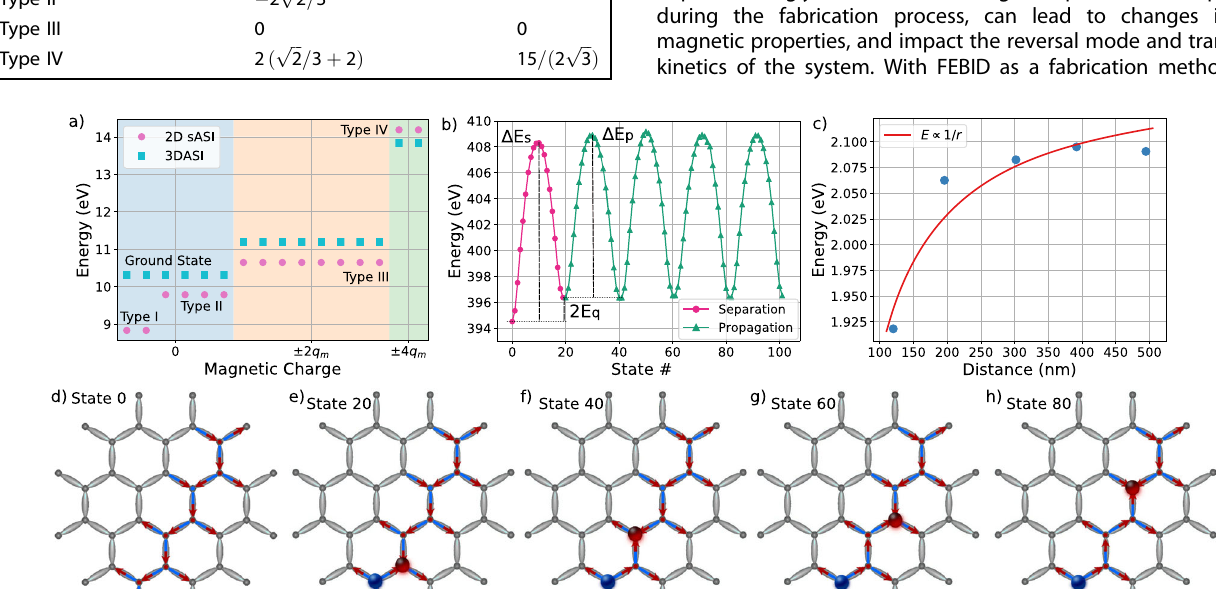
Fig. 2 Magnetostatic energies and minimum energy paths for propagation and separation of charges. a Total energies per vertex calculated with a micromagnetic treatment by taking into account energetic contributions of the exchange and demagnetization fi elds, where every possible magnetic con fi guration in a 2DsASI (circles) and in our 3DASI (squares) was considered, as illustrated in Supplementary Figs. 3, and 4, respectively. b Minimum energy paths to separate (magenta) the two magnetic charges by switching one ellipsoids magnetization in the ground state, and propagating it further through the lattice in a constant direction (green). The difference of saddle points and the corresponding minima yields the separation barrier Δ E s and propagation barrier Δ E p , while the energy of the lattice increases by 2 E q ≈ 2 eV due to the two additional charge defects. c Interaction energy between the magnetic charges after monopole separation and during propagation, which follows a 1/ r Coulomb Law. d – h Schematic illustrations of the magnetization con fi gurations for the ellipsoids in the DS with the positive (dark red) and negative (dark blue) charged magnetic monopoles. Snapshots of magnetizations are depicted in Supplementary Fig. 5, and animations for switching processes are available online.